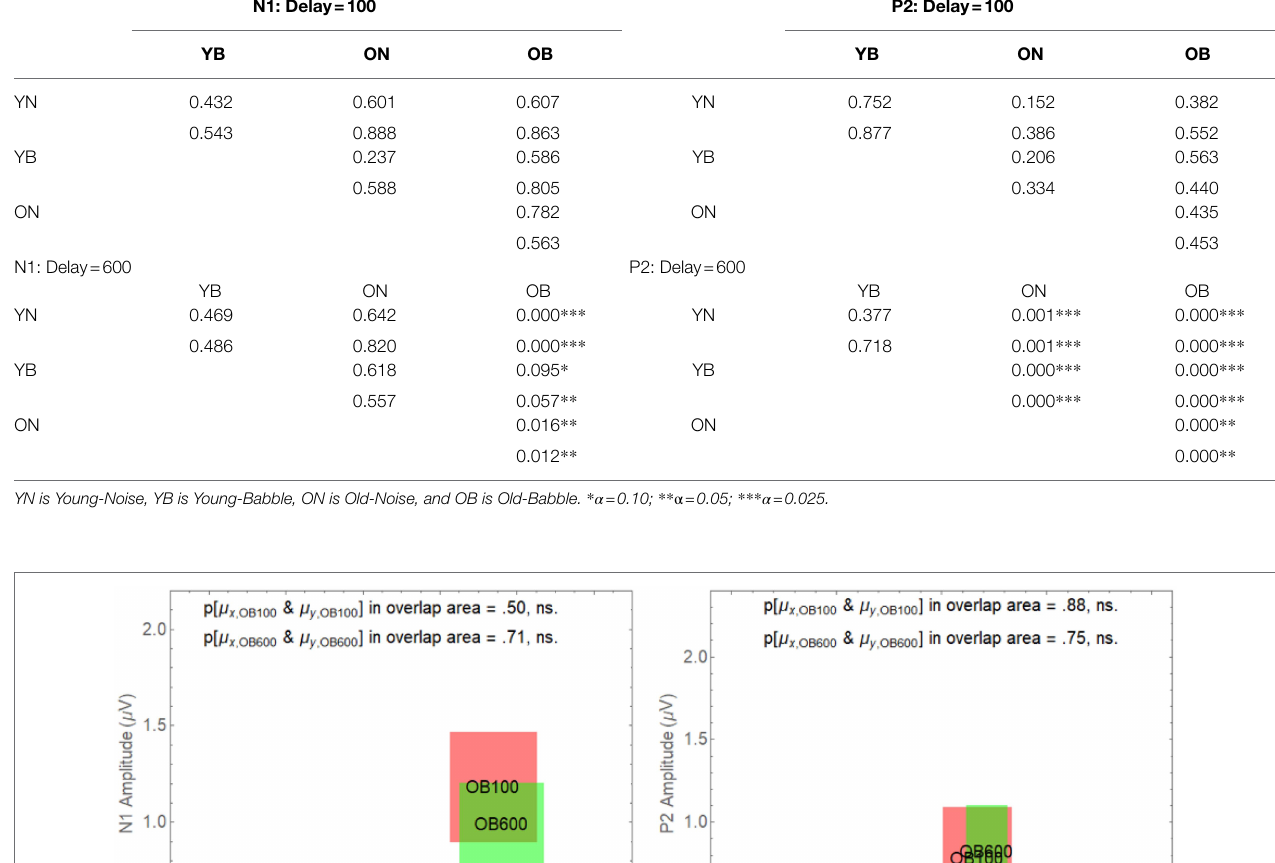
TABLE 2 | The degree of overlap of the Pairs of CI Rectangles at two delays for two different waveforms. N1: Delay = 100